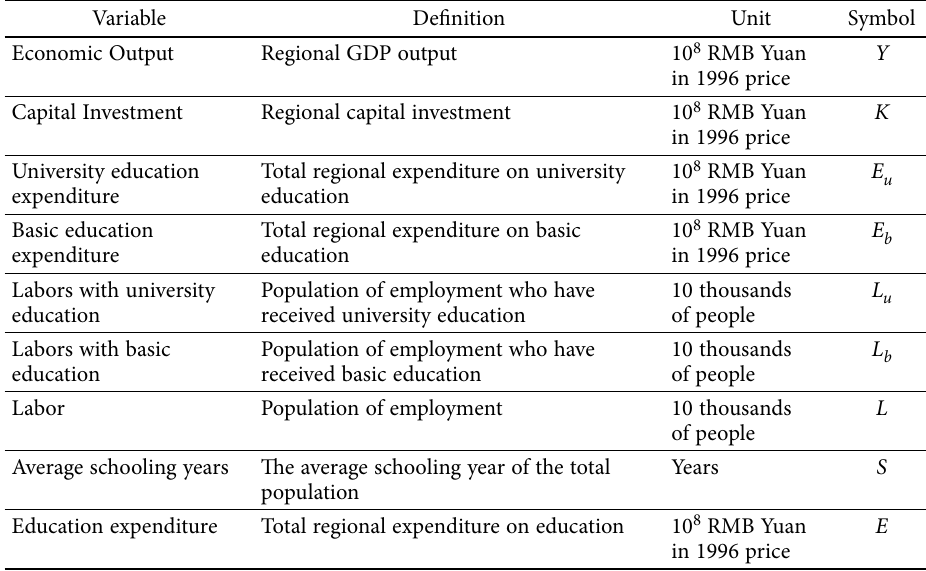
Table 1. Description of